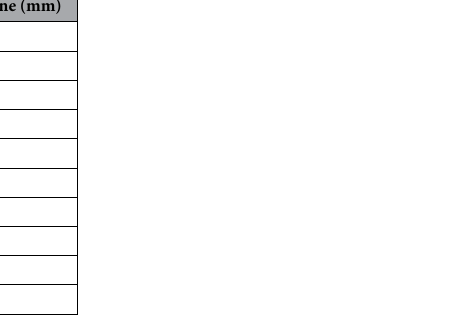
Table 1. Antibiotic resistance profile of S. rochei ANH.